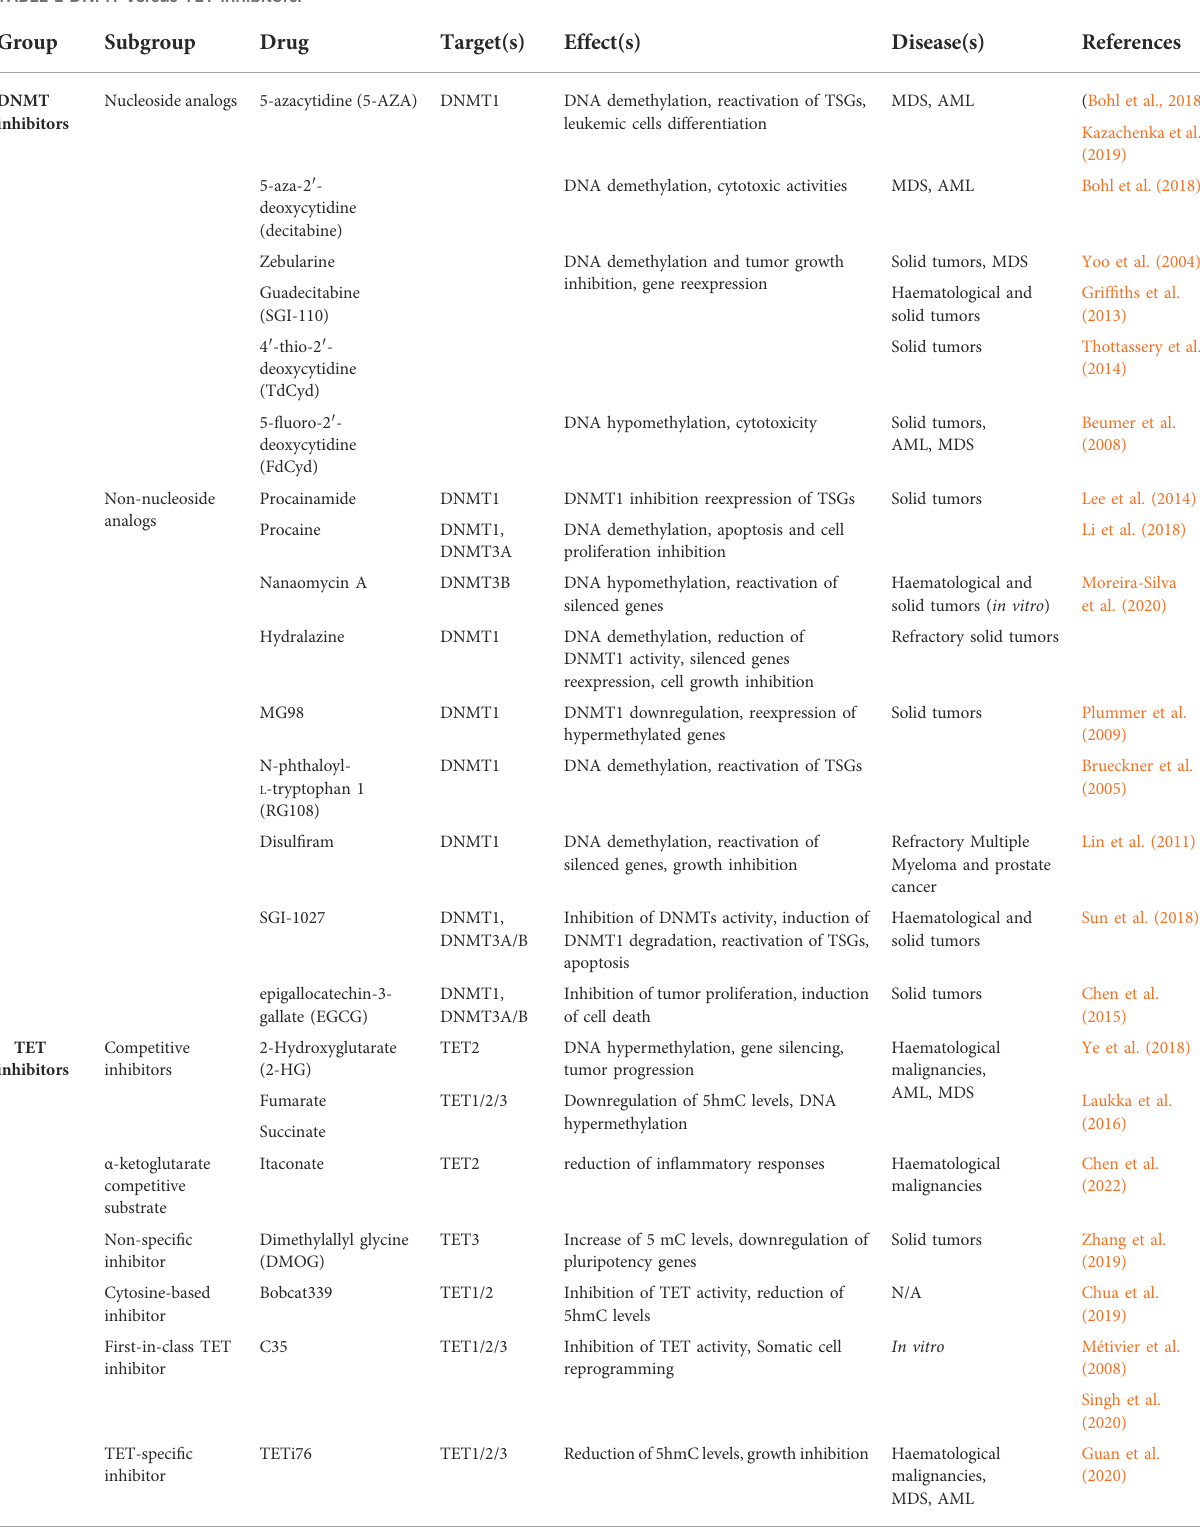
TABLE 1 DNMT versus TET